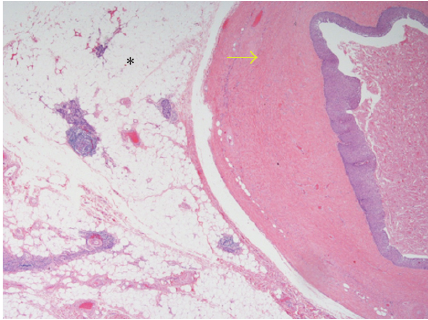
Figure8:H&E2.5ximageshowingtheepidermoidcystwall(yellow arrow) and the normal thymus tissue ( ∗